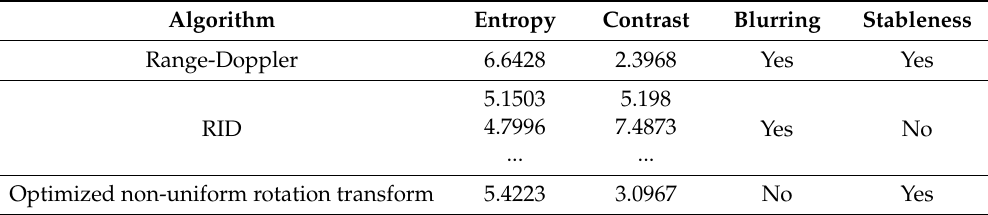
Table 3. Algorithm